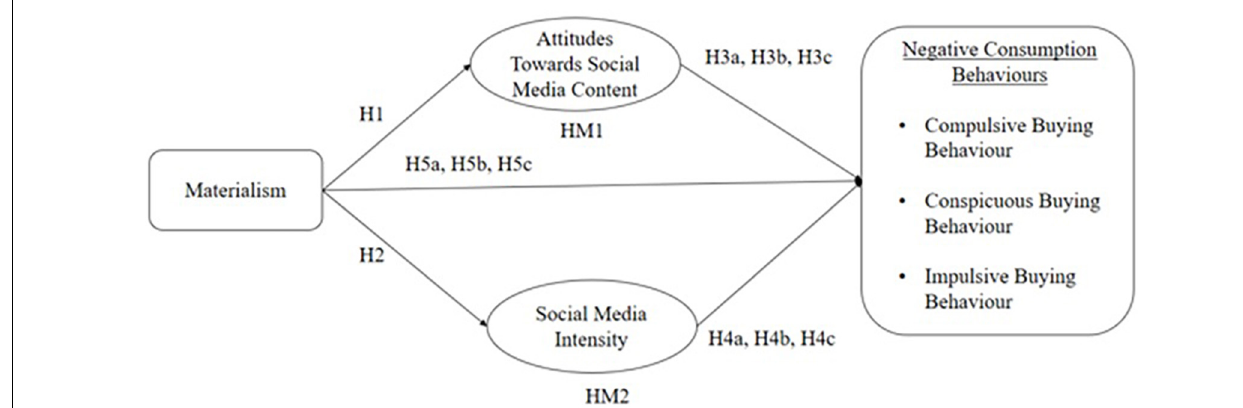
FIGURE 1 | Conceptual framework.